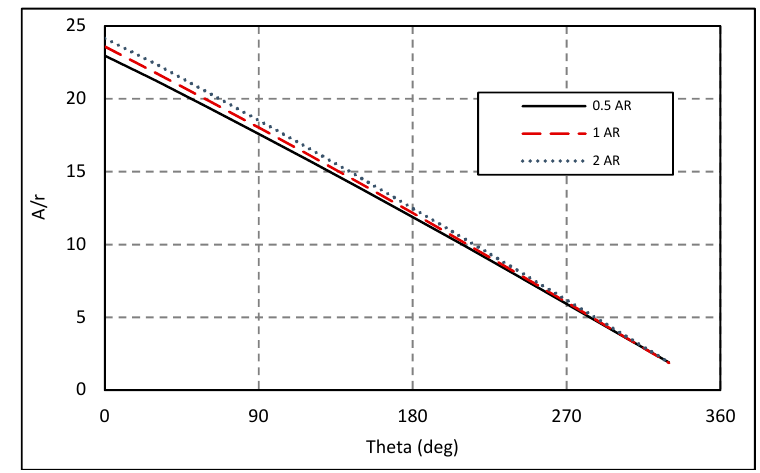
Figure 11. Volute A/r distributions to match MFP.